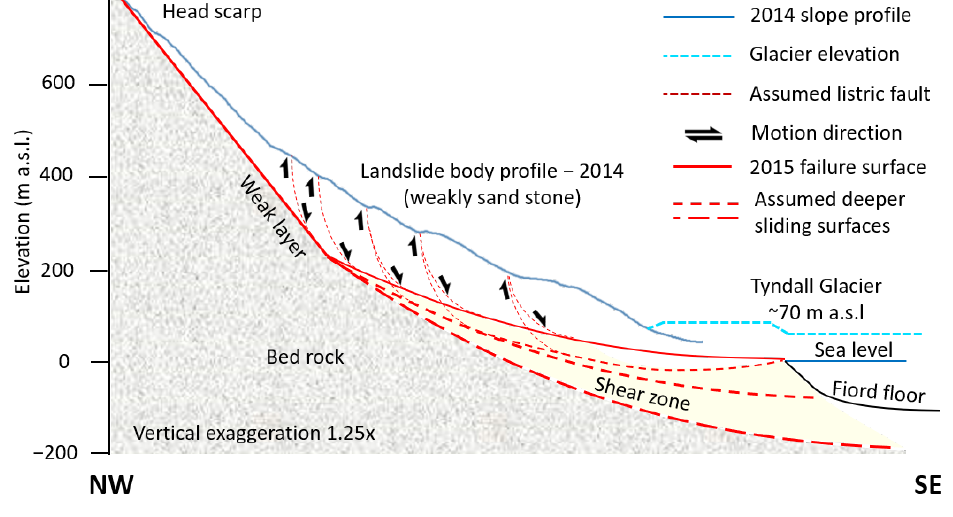
Figure 4. Interpretation of the landslide dynamics and the possible evolution of the sliding surface before the landslide (modified from Franco et al.